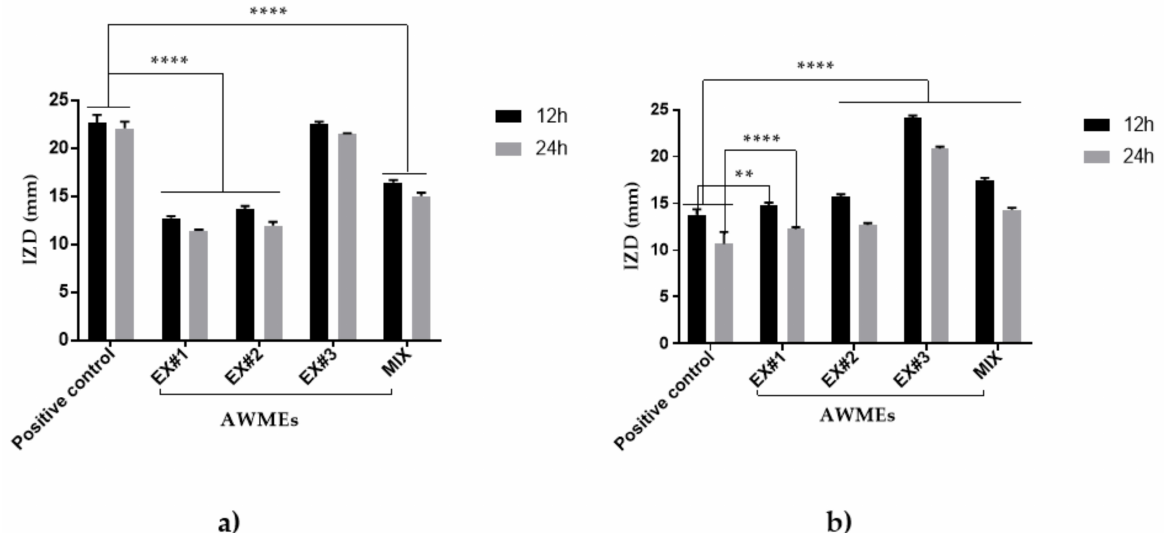
Figure 3. Susceptibility of ( a ) A. hydrophila and ( b ) A. salmonicida bacteria strains to various SEs measured by Disk diffusion assay. The bacteria subjected to AWME1 (Ex#1), AWME2 (Ex#2), and AWME3 (Ex#3), respectively, and a mixture of three extract (Mix) adjusted to the same 40 mg/mL concentration. The IZD values calculated after 12 h and 24 h of incubation at 26 ◦ C by measuring the diameter of inhibition zones (IZD) surrounding of the discs (in mm). Doxycycline (DOX) 100 µ g/mL used as a recommended antibacterial positive control. All values are represented as mean ± SD, in triplicate ( n = 3). All results analyzed by two-way ANOVA, followed by Tukey Multiple Comparisons Test. Data represented as a significant difference when it was compared with the positive control, and p -Value was ranged between ** p = 0.0047 and **** p <